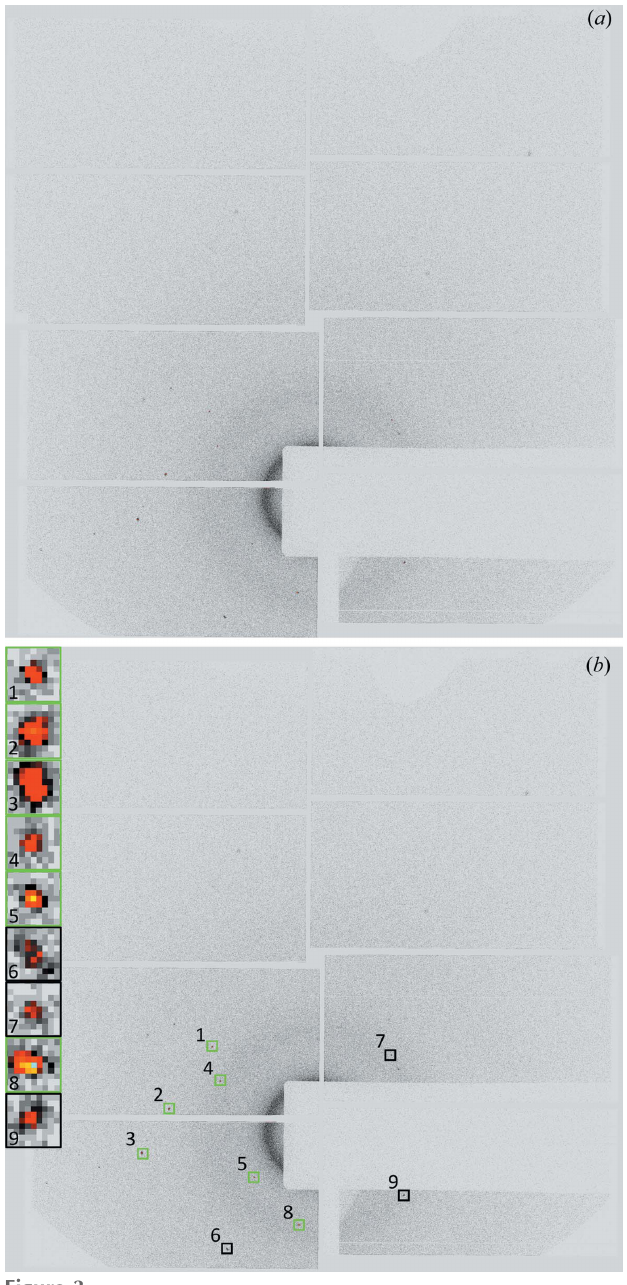
Figure 3 ( a ) Raw detector frame from the PtPOP dataset. This frame will be referred to as Data Frame 1. ( b ) During the spot finding process, most of the intense spots are found (indicated by the six green squares). Unidentified spots can be included later if they agree with the predicted spot positions derived from the calculated OM, which is the case for the three spots enclosed by black squares. Zoomed-in insets of the nine spots are shown on the